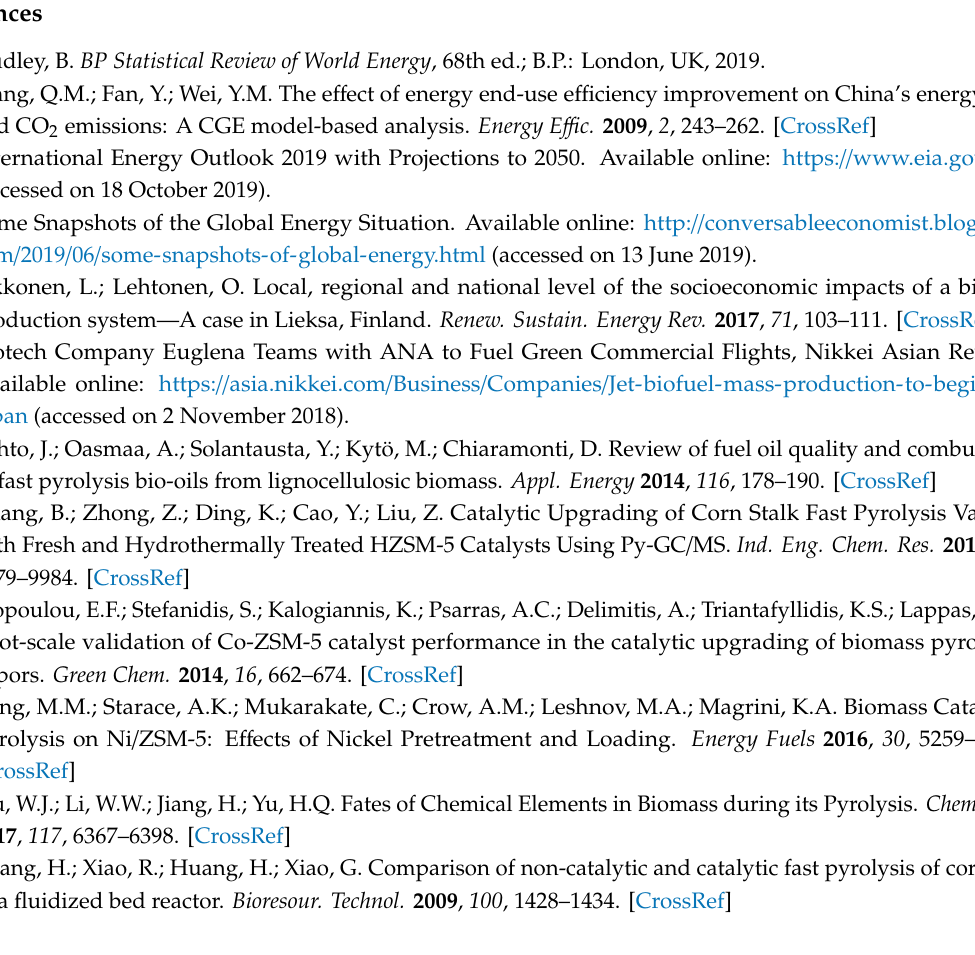
Figure S1: TG-DTA spectrum of (a) cellulose (b) cellulose with Ni2Fe3 catalyst. Table S1: Specific bio-oil compounds measured by GC-MS without catalyst. Table S2: Specific bio-oil compounds measured by GC-MS with Ni2Fe3 catalyst. Table S3: Specific bio-oil compounds measured by GC-MS with ZSM-5 catalyst. Table S4: Specific bio-oil compounds measured by GC-MS with Ni2Fe3 / ZSM-5 catalyst. Table S5: Specific bio-oil compounds measured by GC-MS with ZSM-5 catalyst. Table S6: Specific bio-oil compounds measured by GC-MS with Ni2Fe3 / ZSM-5